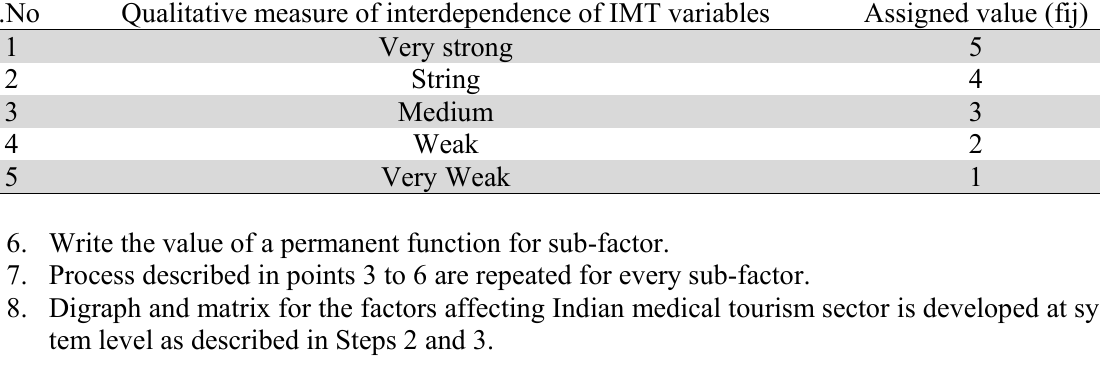
The values of interdependence of Indian Medical Tourism variables: